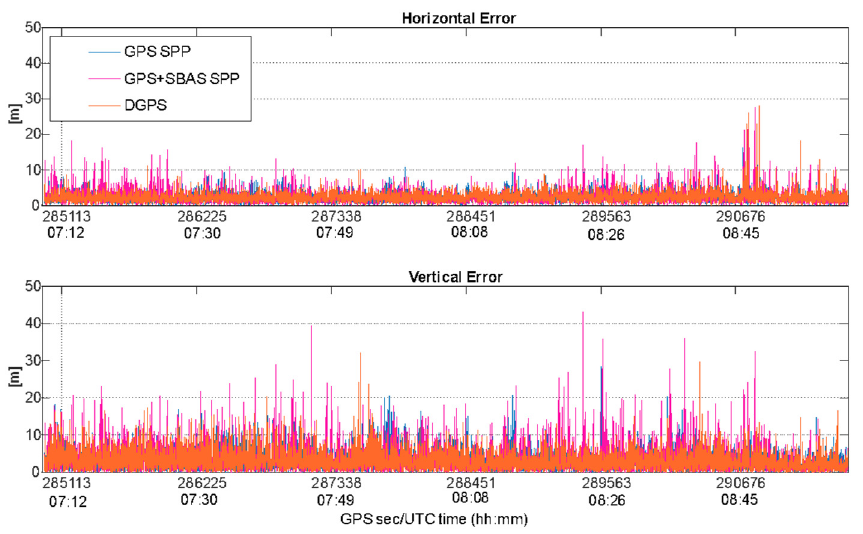
Figure 12. Horizontal and vertical positioning errors (in meters) as function of the time for GPS SPP (blue line), GPS + SBAS SPP (magenta line) and DGPS (orange line) configurations applied to data from Xiaomi Mi 8.